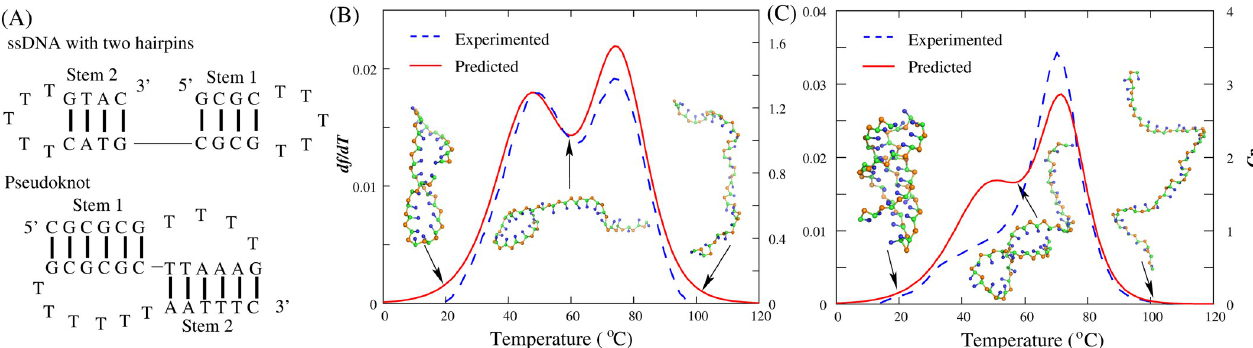
Fig 6. The stability prediction for an ssDNA with two hairpins and a DNA pseudoknot in the present model. (A) The schematics of secondary structure for the ssDNA with two hairpins (top) and the DNA pseudoknot (bottom). (B,C) The comparisons between predictions (solid lines) and experiments (dotted lines) for the two ssDNAs in (a). df / dT : the first derivative of predicted f with the temperature. C typical 3D structures predicted at different temperatures shown with PyMol (http://www.pymol.org).